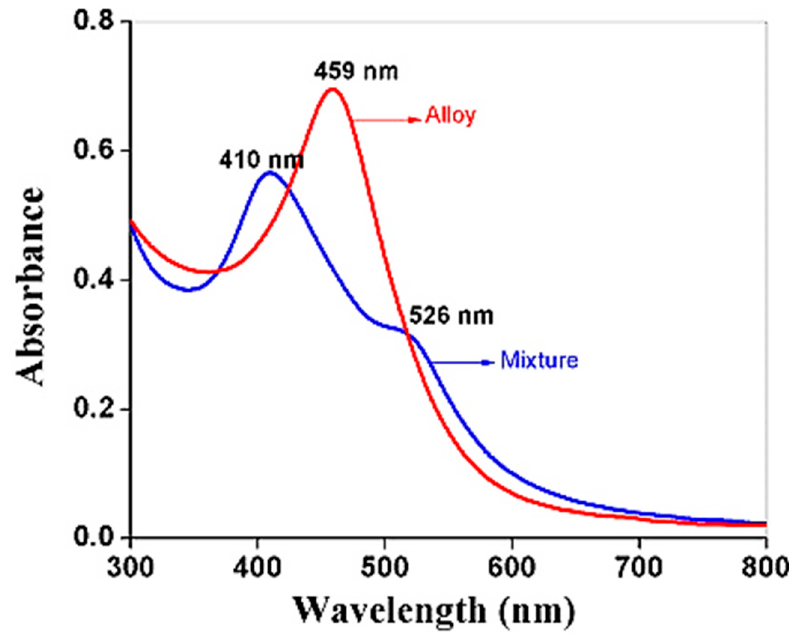
Figure 1. UV-Vis absorption spectra (SPR) of AgAu (0.5:0.5) concentration.